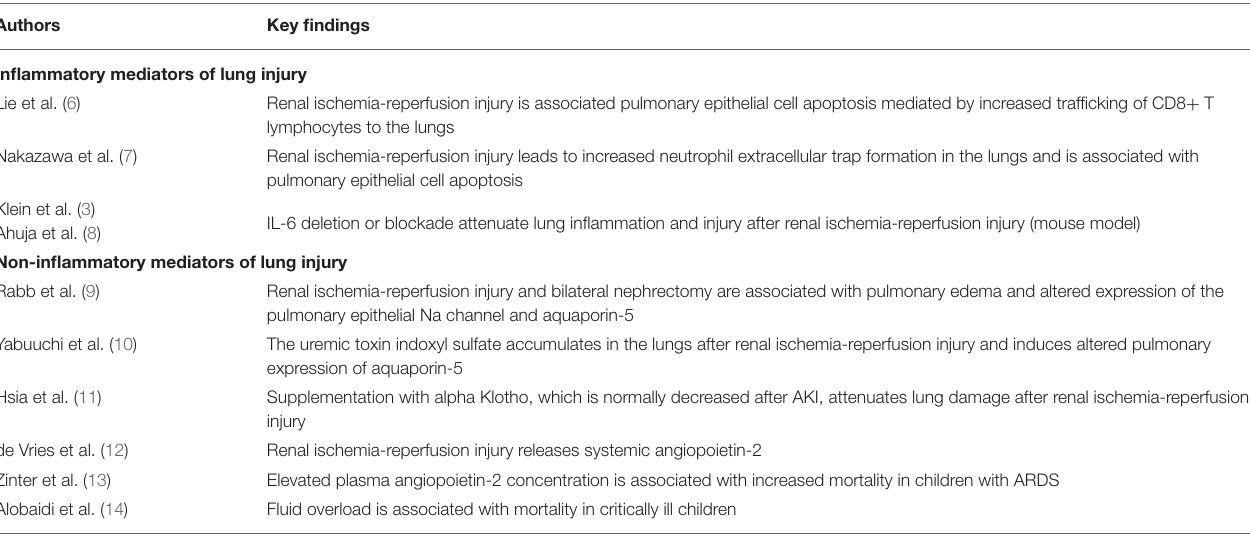
TABLE 1 | Selected publications highlighting kidney mediated lung injury. Authors Key findings Inflammatory mediators of lung